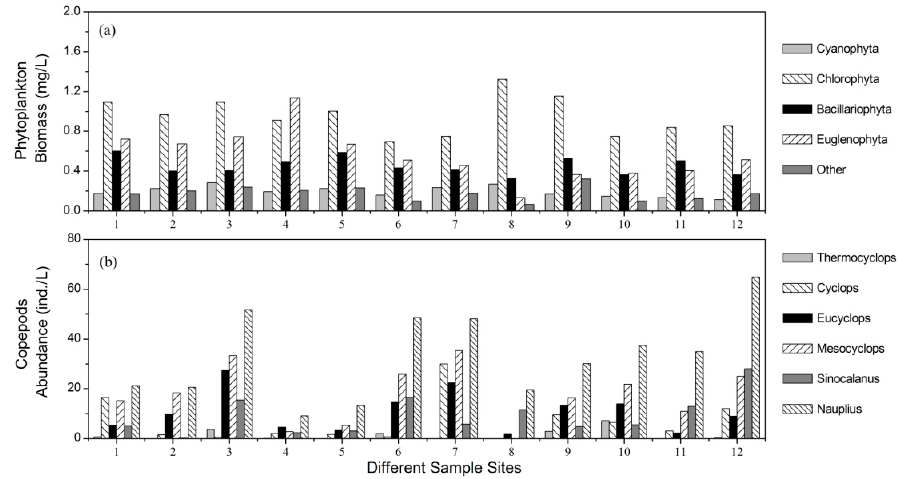
Figure 3. The community compositions of ( a ) phytoplankton and ( b ) copepods at different sites.